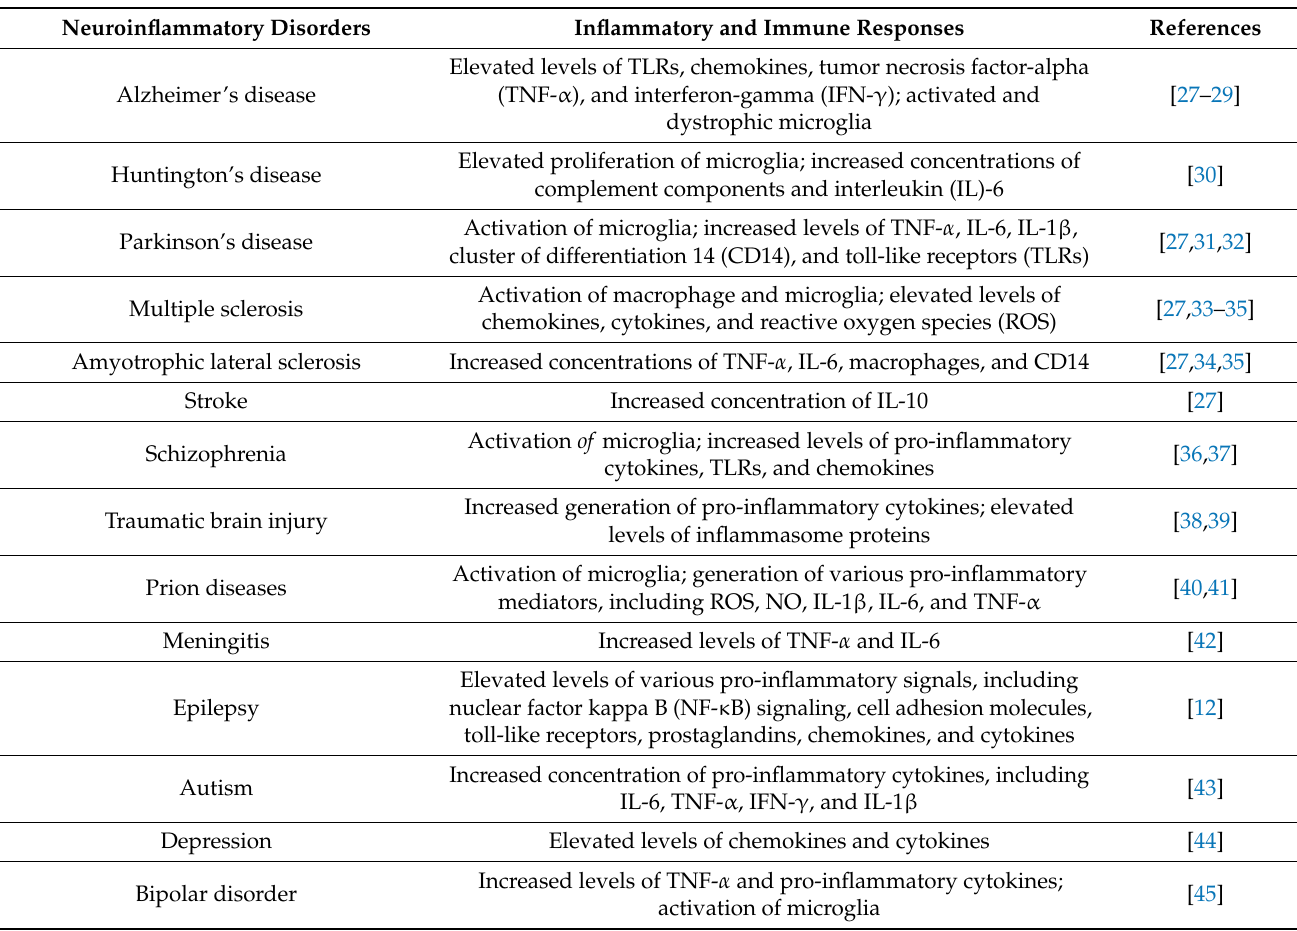
Table 1. Role of inflammatory and immune responses in neuroinflammatory